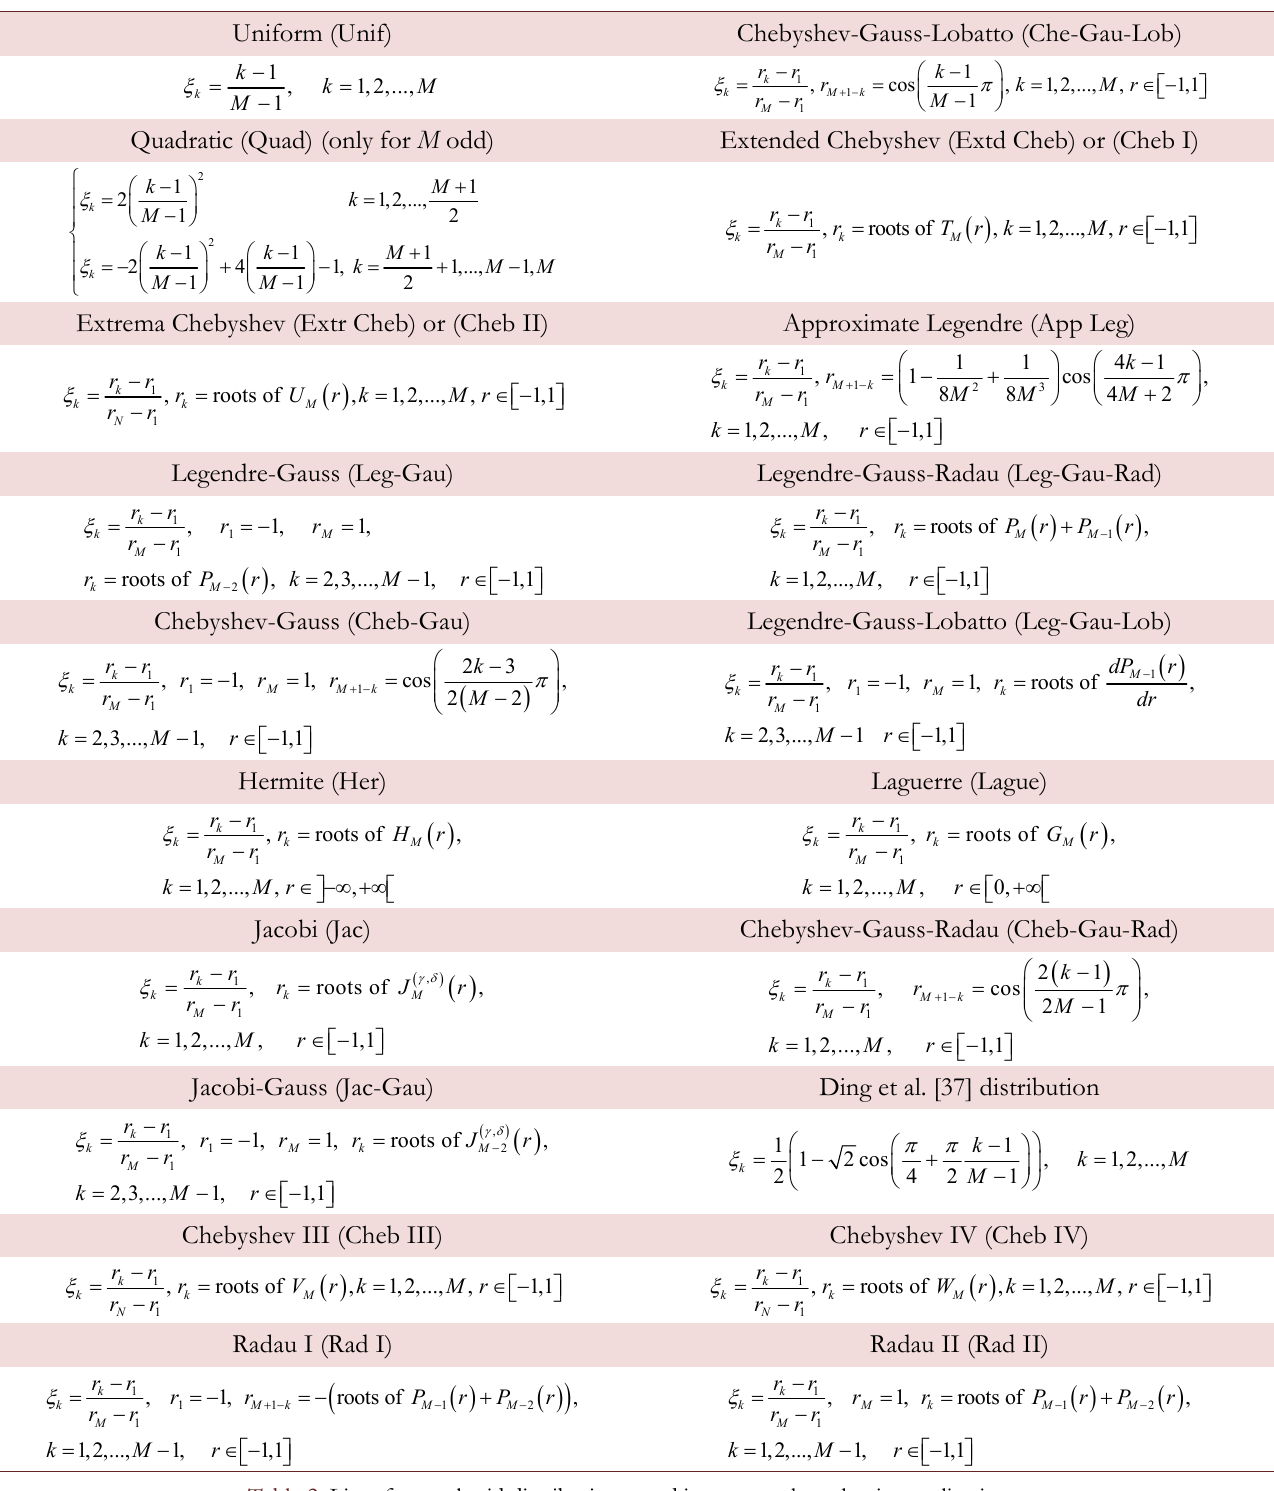
Table 2: List of several grid distributions used in structural mechanics